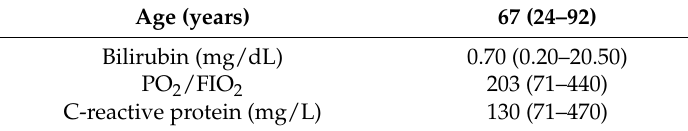
Figure 2. Mean (± SE) blood lactate clearances in survivors (closed circles) and non-survivors (open circles) over 48 h. Adipose tissue lactate clearance increased significantly over time in survivors ( p < 0.001), and remained unchanged in non-survivors ( p = 0.09). Tissue clearance was higher in survivors compared to non-survivors at H0–H12 ( p = 0.02), H0–H20 ( p = 0.02), and H0–H24 ( p = 0.02) (Figure 3).